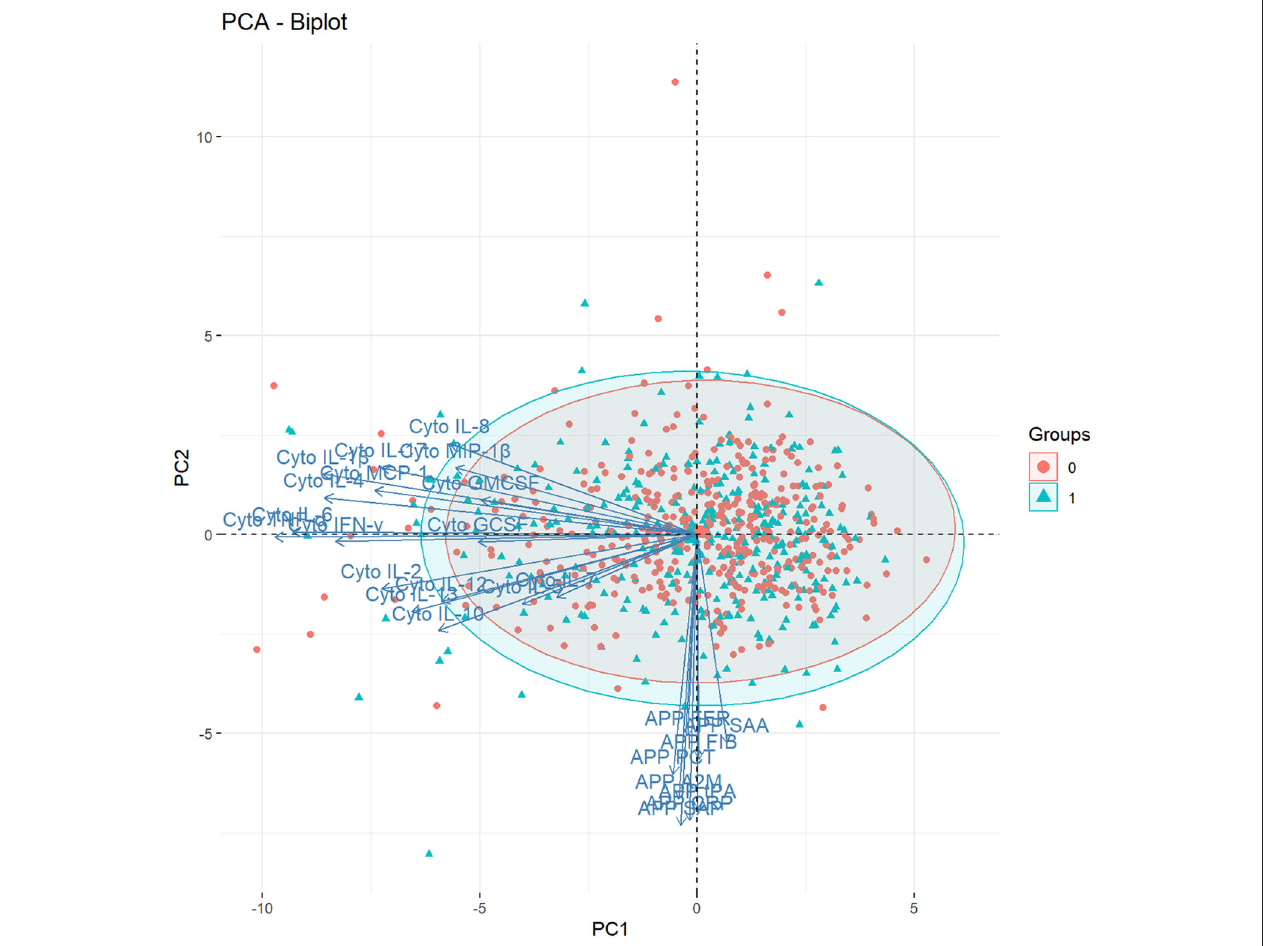
FIGURE 3 | Biplot showing the factor loadings by the individual cytokines and acute phase proteins on the first two principal components (PC1 and PC2), and the values of these components for each individual in the study [ n 747, Groups: 0 unaffected controls (red circles); 1 ASD-cases (blue triangles)], in the = = = two-dimensional component space generated by PC1 and PC2. A2M, α -2 Macroglobulin; APP, Acute Phase Protein; CRP, C-Reactive Protein; Cyto, Cytokine; FER, Ferritin; FIB, Fibrinogen; IL-1 β , Interleukin-1 β ; IL-2, Interleukin-2; IL-4, Interleukin-4; IL-5, Interleukin-5; IL-6, Interleukin-6; IL-7, Interleukin-7; IL-8, Interleukin-8; IL-10, Interleukin-10; IL-12, Interleukin-12; IL-13, Interleukin-13; IL-17, Interleukin-17; GCSF, Granulocyte Colony-Stimulating Factor; GMCSF, Granulocyte